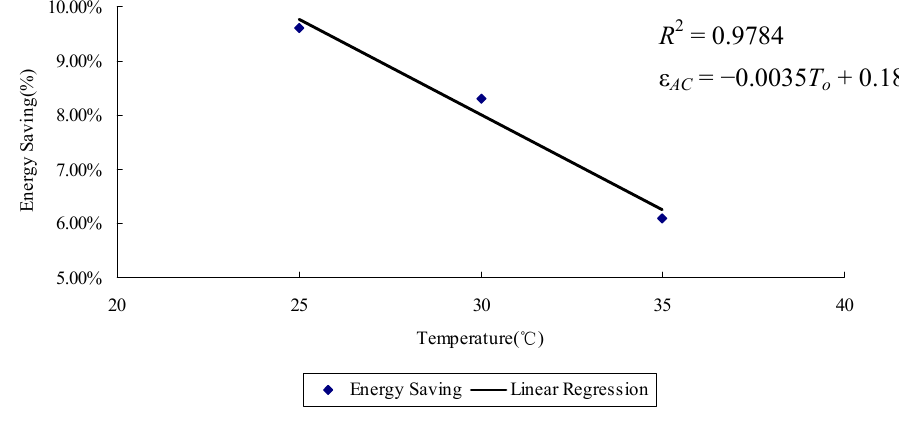
Figure 15. Energy saving potential of various RH.